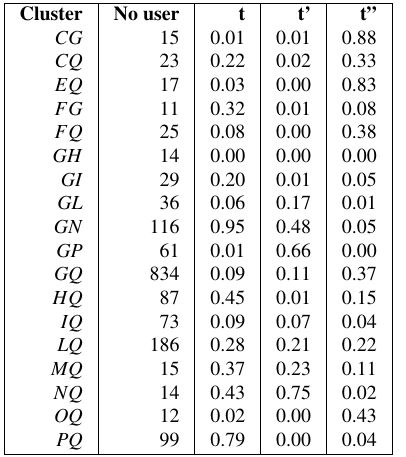
Table 6. Parameters of classifier f t , t (cid:48) ∨ t (cid:48)(cid:48) for sequences with two categories. Cluster No user t t’ t” CG